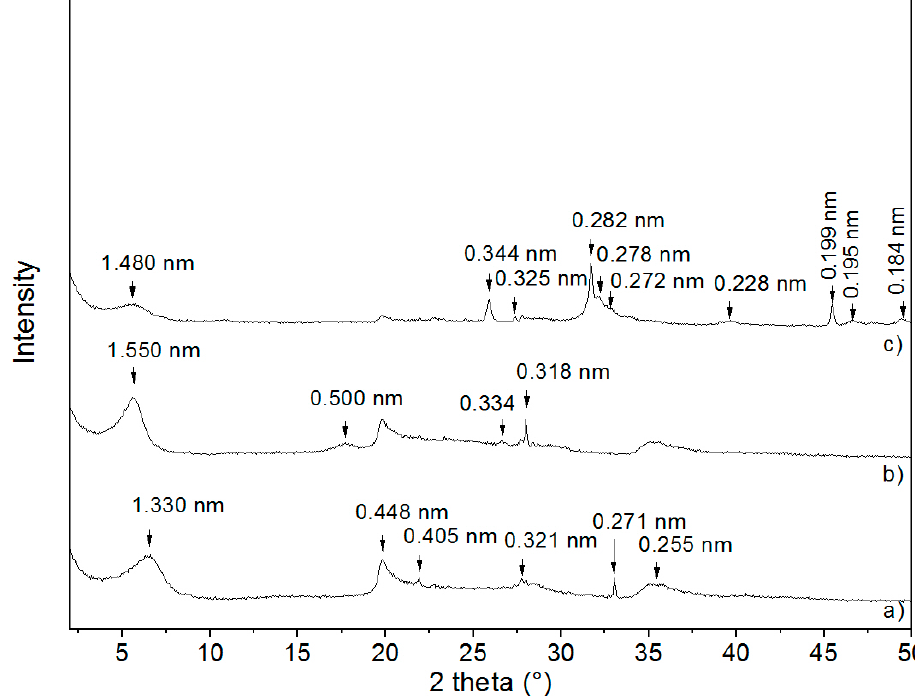
Figure 2. XRD patterns of MMT samples ( a ) NaMMT, ( b ) MCA, ( c ) MCAH CuK radiation.